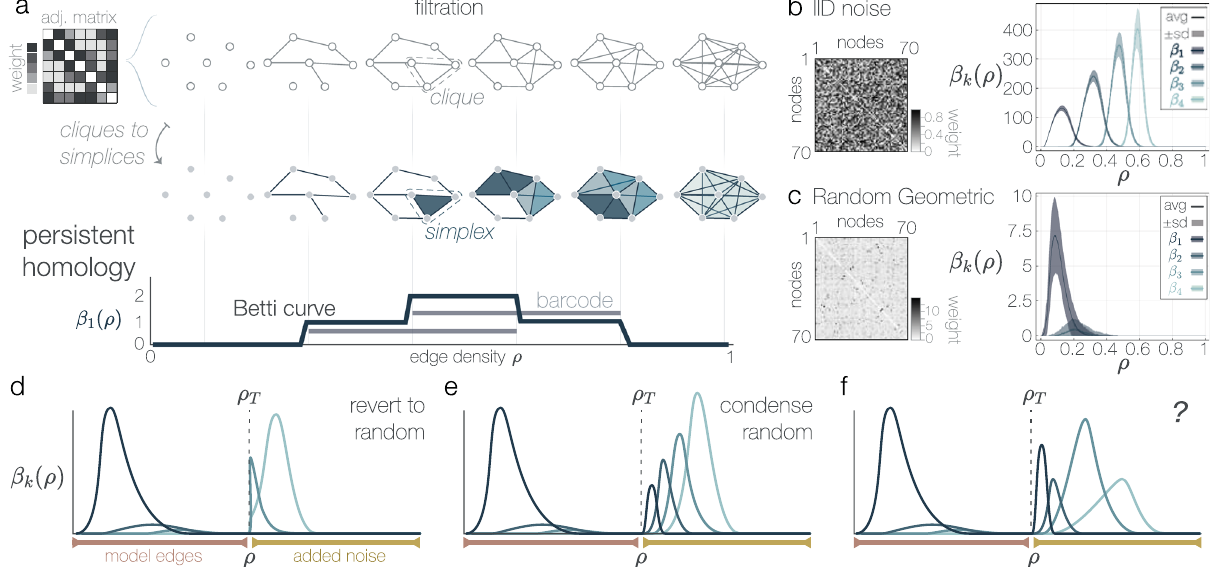
Fig. 2 Through the lens of persistent homology, we imagine three possibilities for the structure of noise added to model networks. a From a weighted network (shown as an adjacency (adj.) matrix), we construct a graph fi ltration in the top row by adding edges to an empty graph one at a time in order of decreasing edge weight. From this fi ltration in the top row we create a sequence of clique complexes (simplices indicated by blue shaded regions) in the middle row on which we compute the persistent homology. We show the barcode (horizontal lines) and Betti curve β 1 ( ρ ) for the resulting persistent homology in the bottom row. b , c An example adjacency matrix and Betti curves of the independent and identically distributed (IID) noise ( b ) and random geometric ( c ) network models. Solid lines indicate the average over 500 replicates and shaded ares correspond to ± 1 standard deviation. d Stylized possibilities for the structure of added noise as perceived by the Betti curves: a reversion to IID noise Betti curves (left), a condensed collection of all four Betti curves following an IID noise pattern (middle), or a Betti curve pattern completely unlike that of IID noise